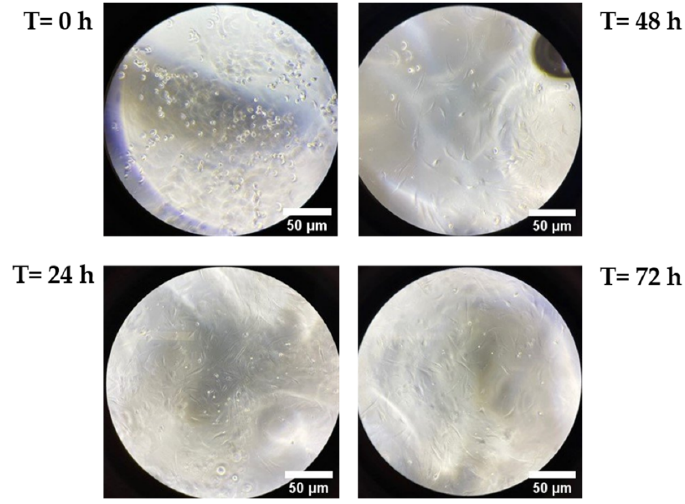
Figure 6. NHDF cells in the hydrogel observed under optical microscope (magnification 10×) after all analyzed times of incubation.